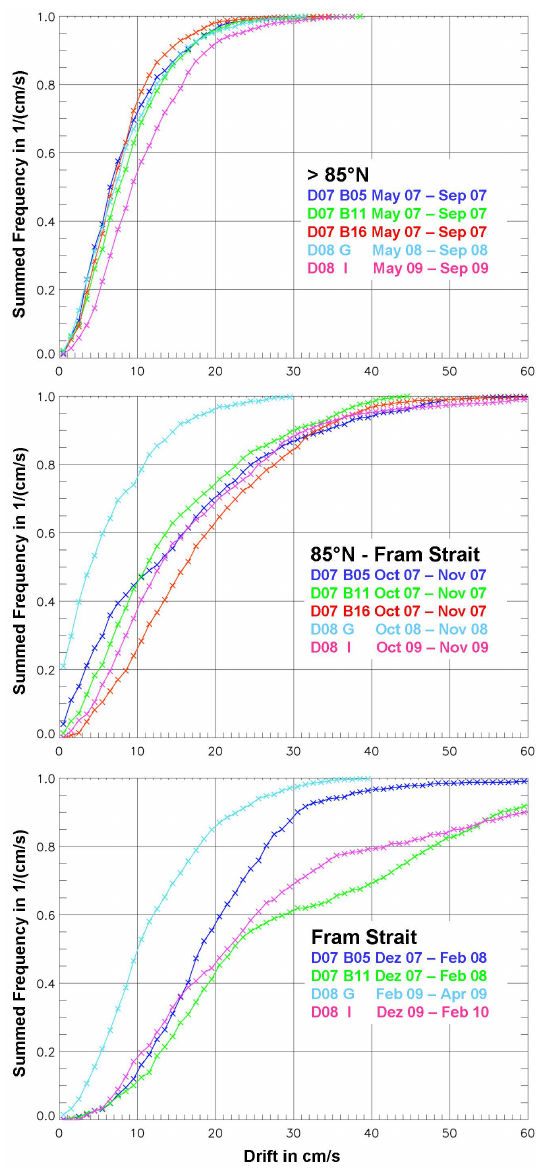
Fig. 5. Histograms of drift velocity for D07 buoys 5, 11, 16 and D08 buoys G, I for different regions of the transpolar drift. Note that the curves hold for different